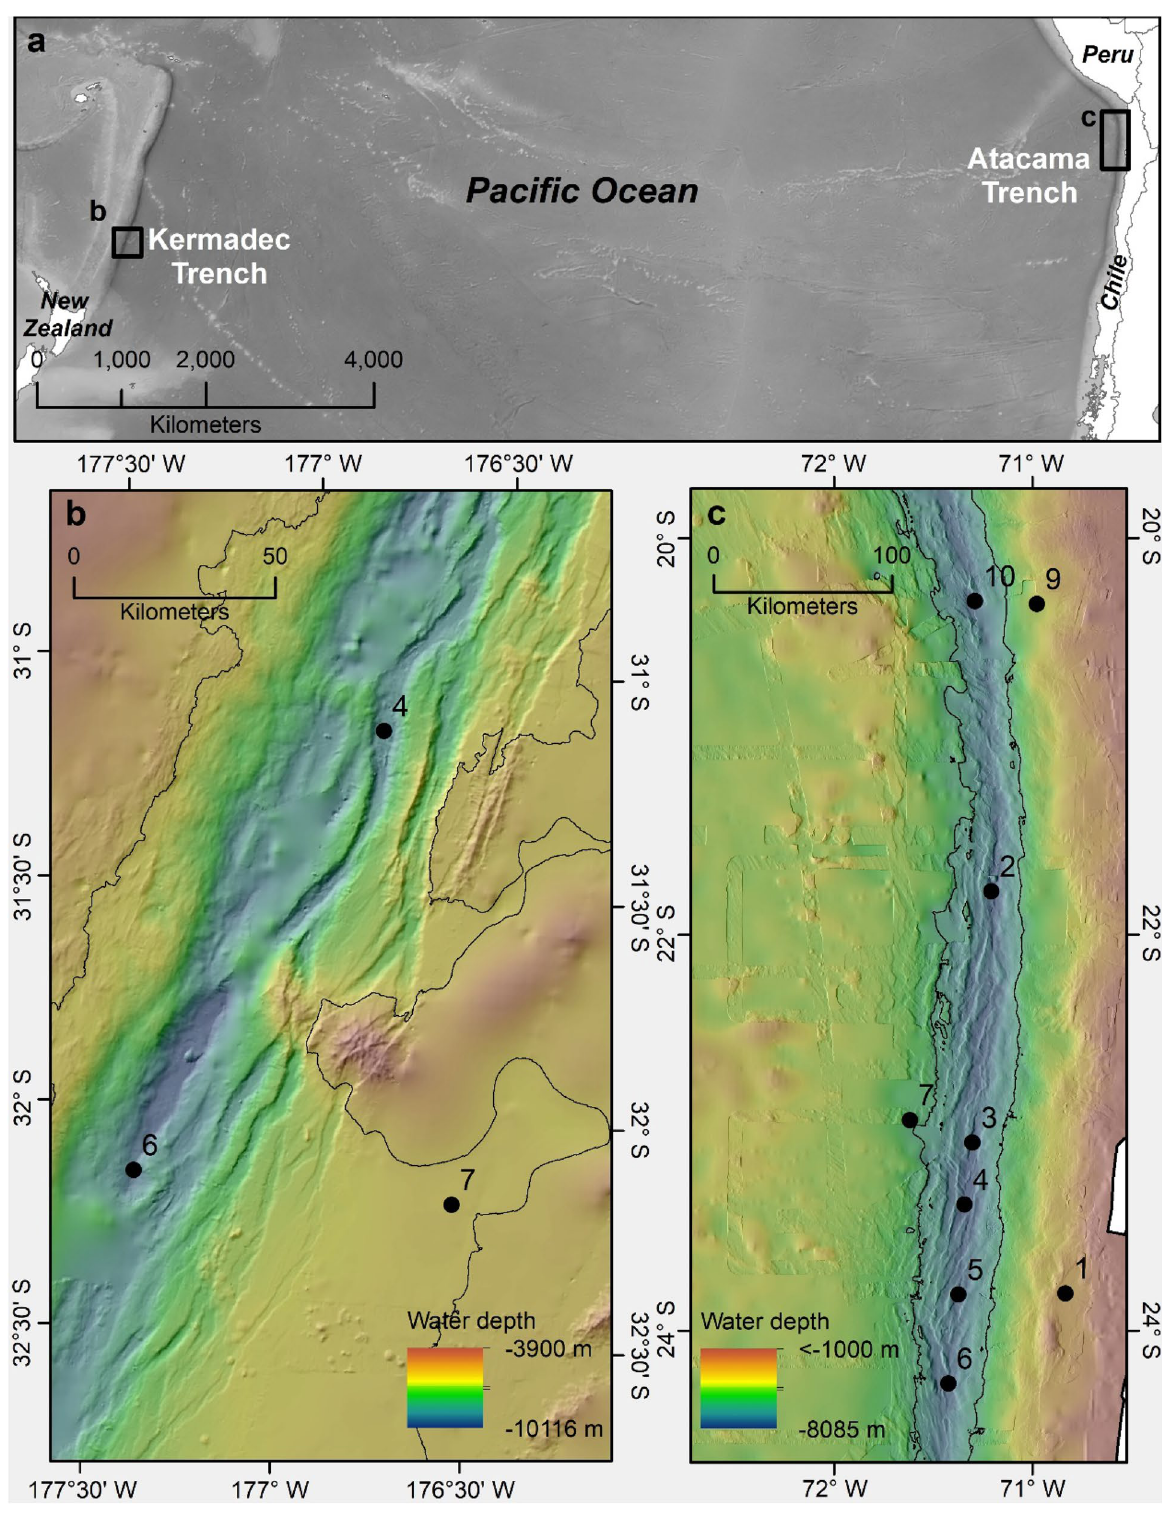
Figure 1. Study areas in the Kermadec Trench and the Atacama Trench regions in the Pacific Ocean ( a ). Detailed bathymetry data with specific sampling sites in the Kermadec Trench ( b ) and Atacama Trench ( c ). The sites were visited during two cruises with RV Tangaroa (TAN1711, 2017) and RV Sonne (SO261, 2018), respectively. Black line in ( b ) and ( c ) indicates the 6000 m depth contour. Black line in b and c indicates the 6000 m depth contour. Map adapted from Ref. 46 . Figure Copyright British Geological Survey UKRI 2021. Bathymetry data were obtained from the Global Multi-Resolution Topography Synthesis 47